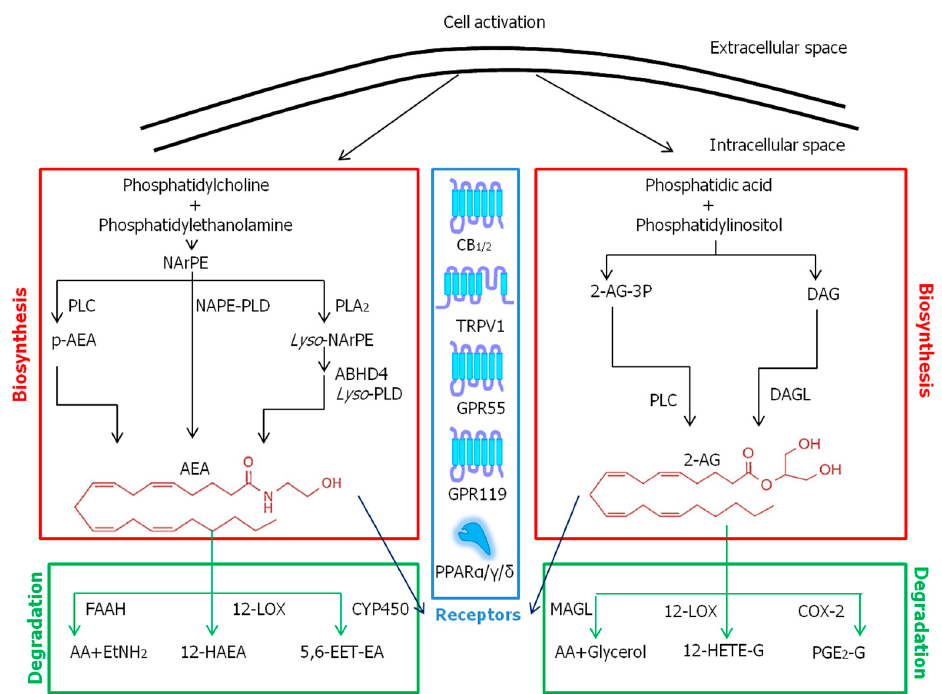
Figure 2. Metabolic pathways and known receptors of ECBs. Abbreviations: 12-HAEA—12-hydroxy- N -arachidoylethanolamine; 12-HETE-G—12-hydroxy eicosatetraenoylglycerol; 2-AG—2-arachidonoylglycerol; 5,6-EET-EA—5,6-epoxyeicosatrienoyl ethanolamide; AA—arachidonic acid; ABHD4— αβ -hydrolase domain 4 protein; AEA— N -arachidonoylethanolamine; CB 1/2 —canna-